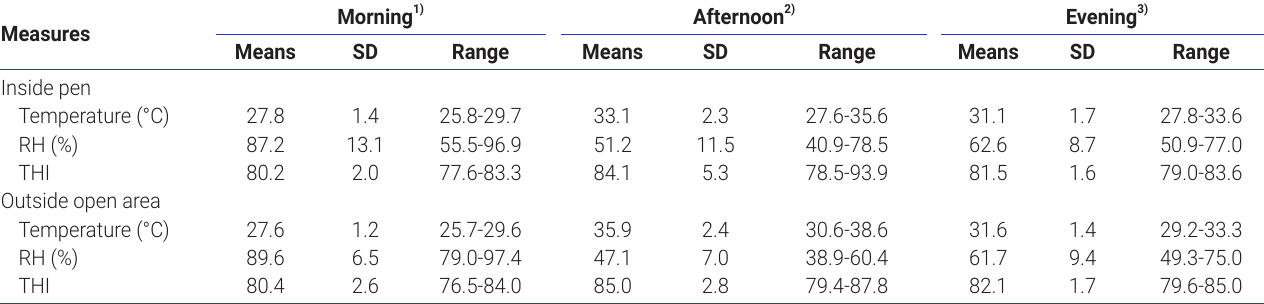
Table 2. Summary of the average meteorological measures from August to September 2019